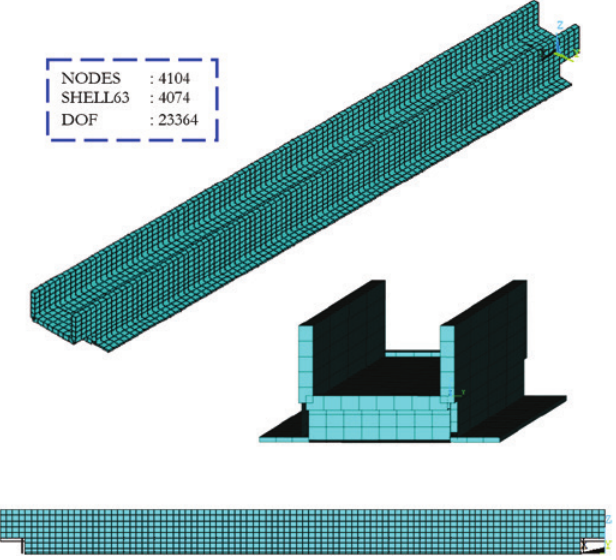
Figure 3 Finite element model of the footbridge: three-dimensional, front and lateral